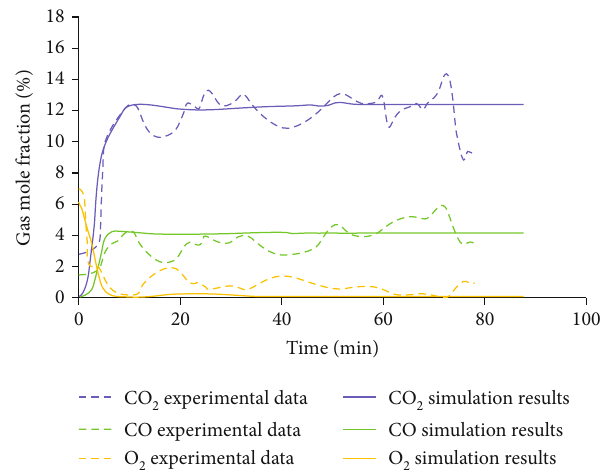
Figure 15: Flue gas composition history match for D block combustion tube numerical simulation.